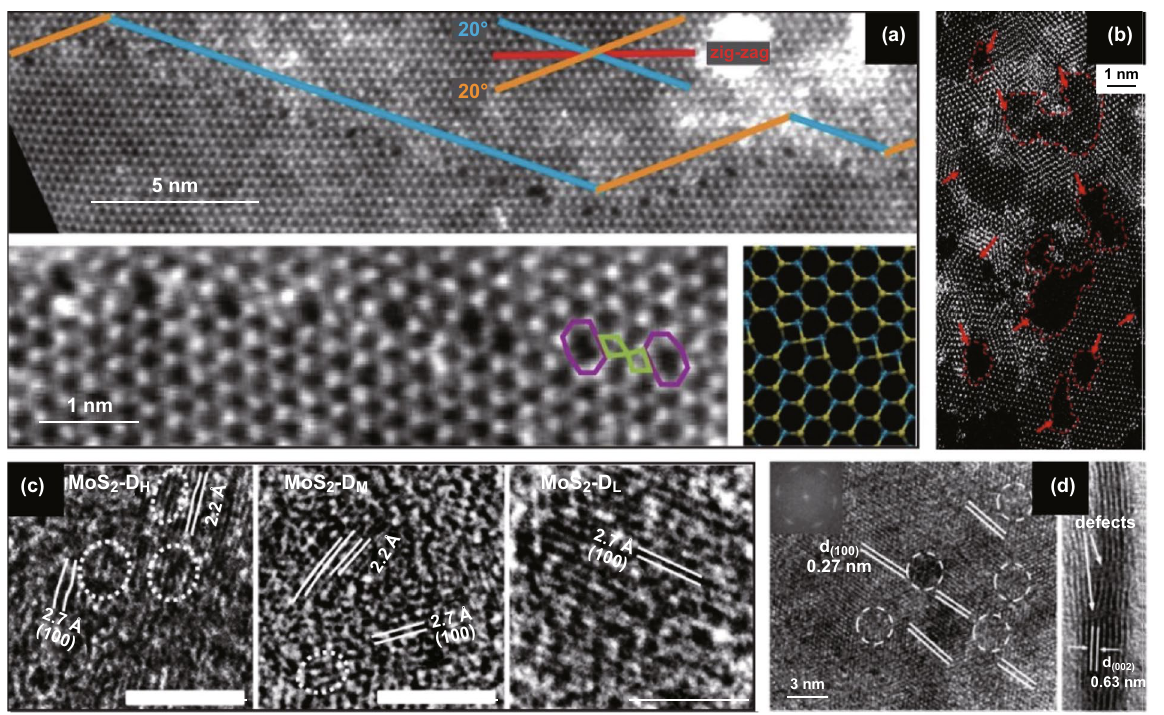
Fig. 17 Intrinsic 1D and 2D defects in 2D TMDCs during the synthesis. a HRTEM-ADF images of 2D MoS 2 including line defects at a mir- ror twin grain boundary (top). Below is the zoomed-in image shows a periodic line of 8–4–4 ring defects along the grain boundary, including an atomistic model on the right. Adapted with permission from Ref. [147]. Copyright 2019, ACS Publications. b Mesoporous (holey) 1T-MoS 2 nanosheet with two-dimensional defects many edge sites synthesised with severe desulphurisation reaction condition between lithium and MoS 2 . Adapted with permission from Ref. [148]. Copyright 2015, ACS Publications. c HRTEM images of engineered sulphur deficient MoS 2 show dislocations and distortions of lattice planes decreases (left to right) from reaction precursor Mo/S ratios of 4:2 (D H ), 4:4 (D M ) and 4:8 (D L ). Adapted with permission from Ref. [149]. Copyright 2019, Nature Publishing Group. d HRTEM micrograph of defect-rich structure of MoS 2 and active edge sites generated by varying precursors during the synthesis process. Adapted with permission from Ref. [150]. Copyright 2013,